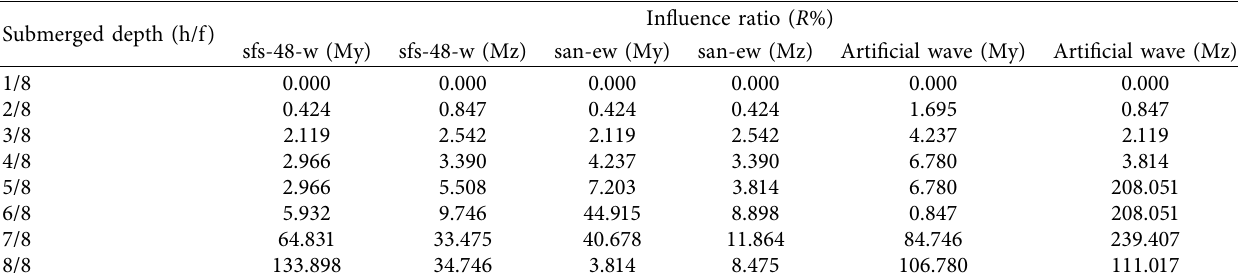
Table 7: Te relation of R and submerged depth at 5L/16 of the arch.